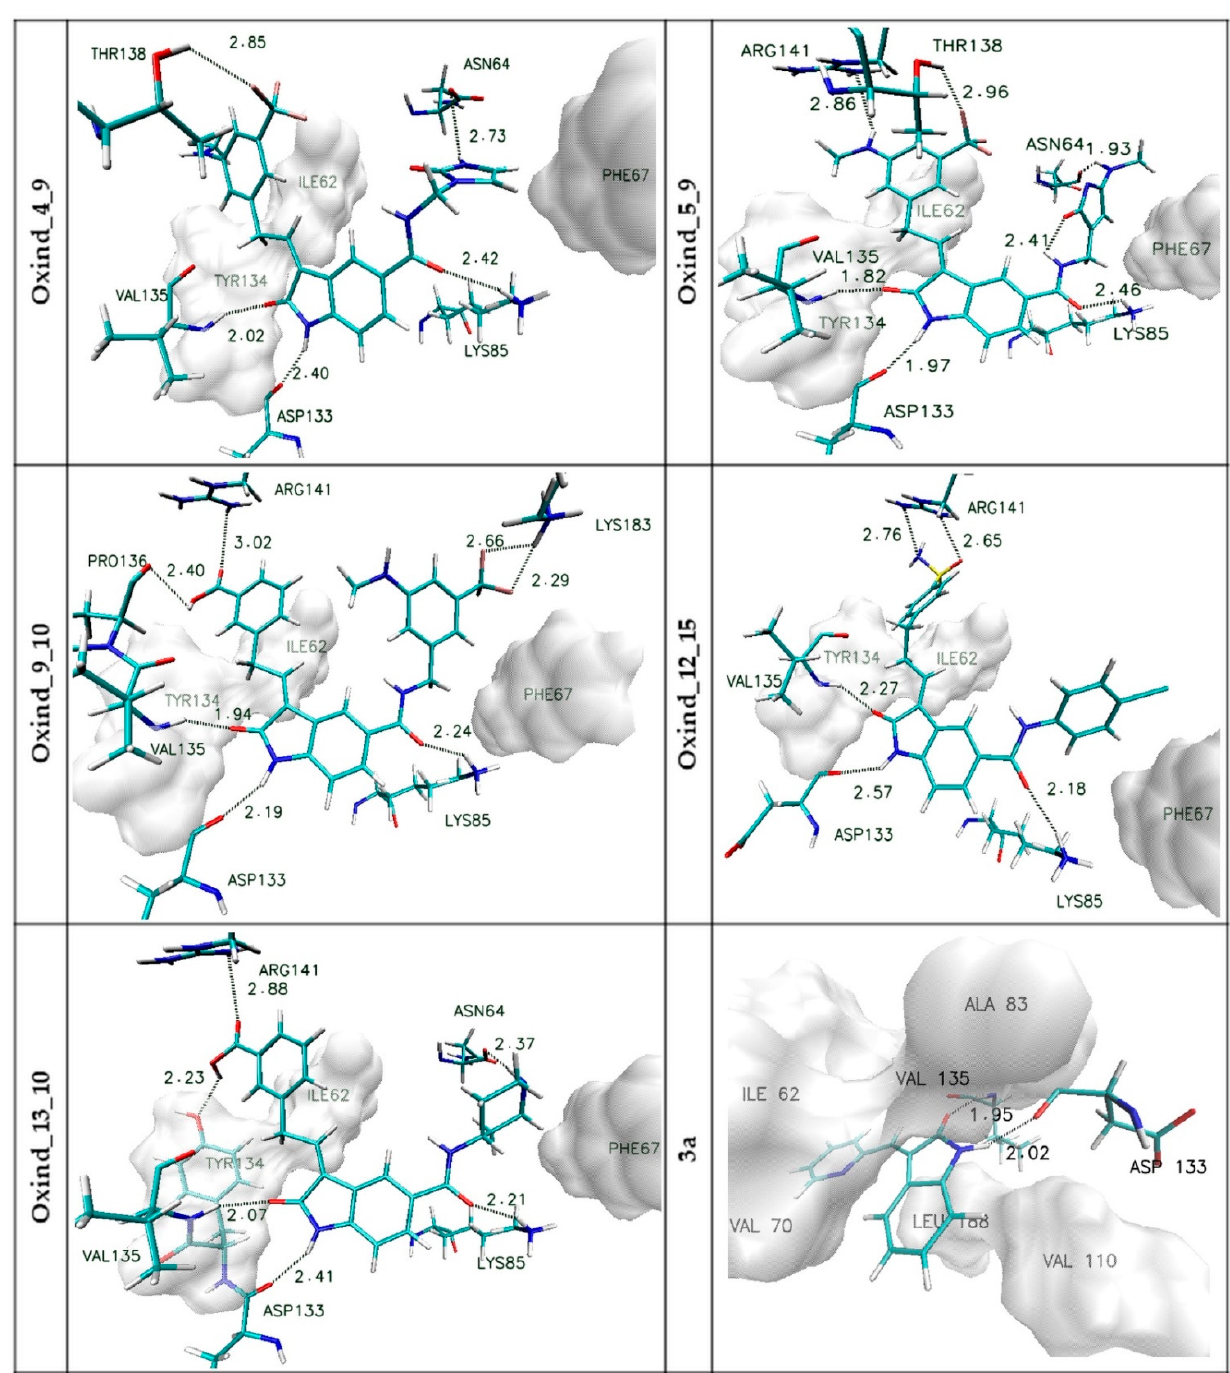
Figure 3. The graphic representations of interactions of oxindole derivatives with the GSK-3 β active site identified during the docking stage. The markings on the left side of individual figures are the names of ligands forming complexes with the active site.